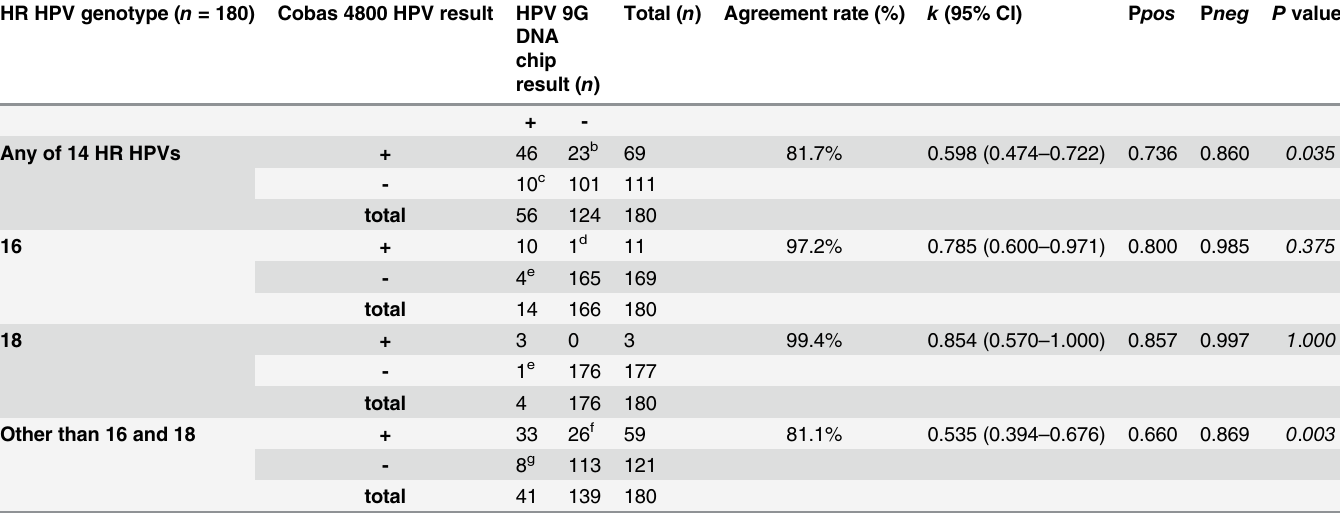
Table 1. Concordance of results between the Cobas 4800 HPV and the HPV 9G DNA chip tests according to HR HPV